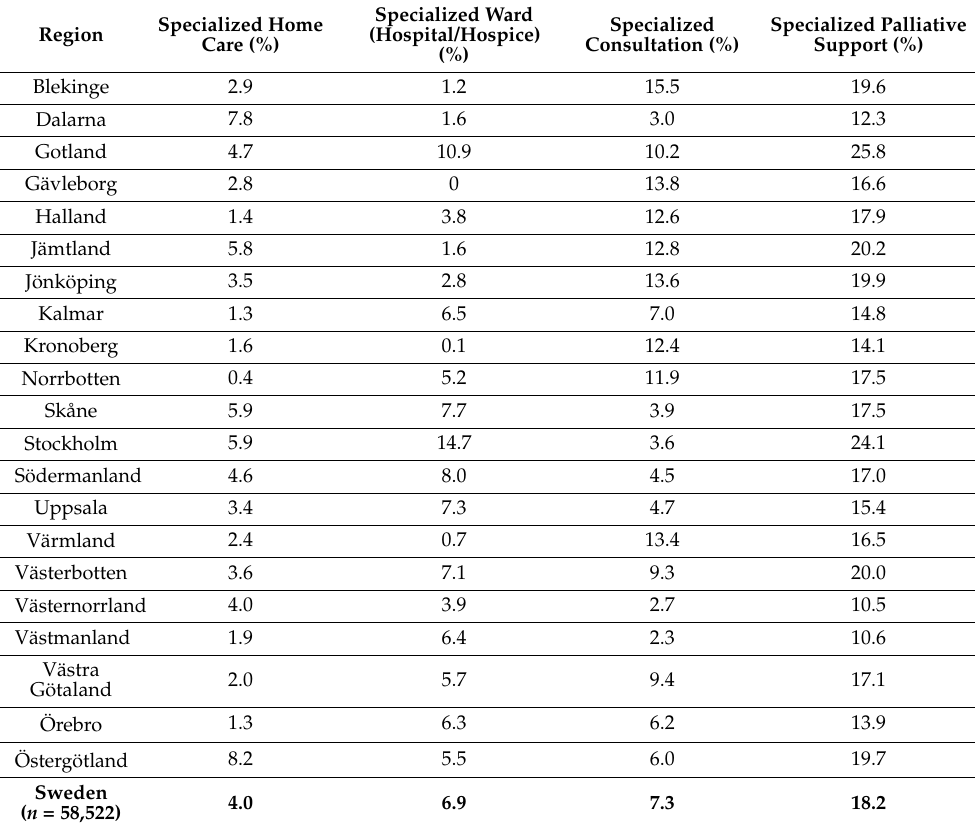
Table 2. Proportions of all dying patients reported to SRPC regardless of diagnosis, place of residence, and level of care who received support from a specialized palliative unit